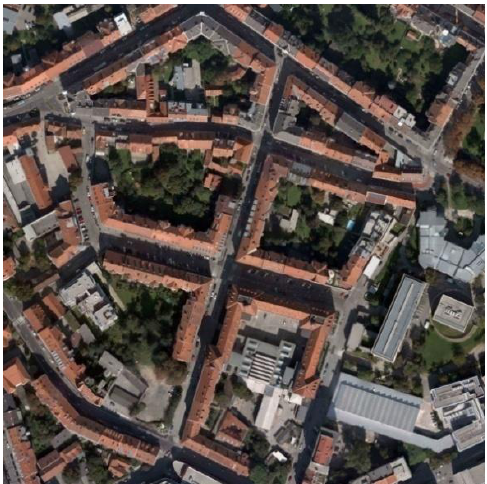
60% sideward. Our aim is to show that an automated property characterization is feasible, not least due to the fact that the overlaps produce a10-image coverage of each terrain point. Figure 3. True Orthophoto of the city of Graz , 400 m × 400 m, at a ground sampling distance of 10 cm. ―True‖ in that orthophoto implies the aerial photograph has been re-projected considering the elevation of the buildings, so that one cannot see any of the building facades. Shown here are 216 building details: Brockmanngasse, Kopernikusgasse; UltraCamX, acquired in 2007 [Courtesy of Microsoft-Graz].